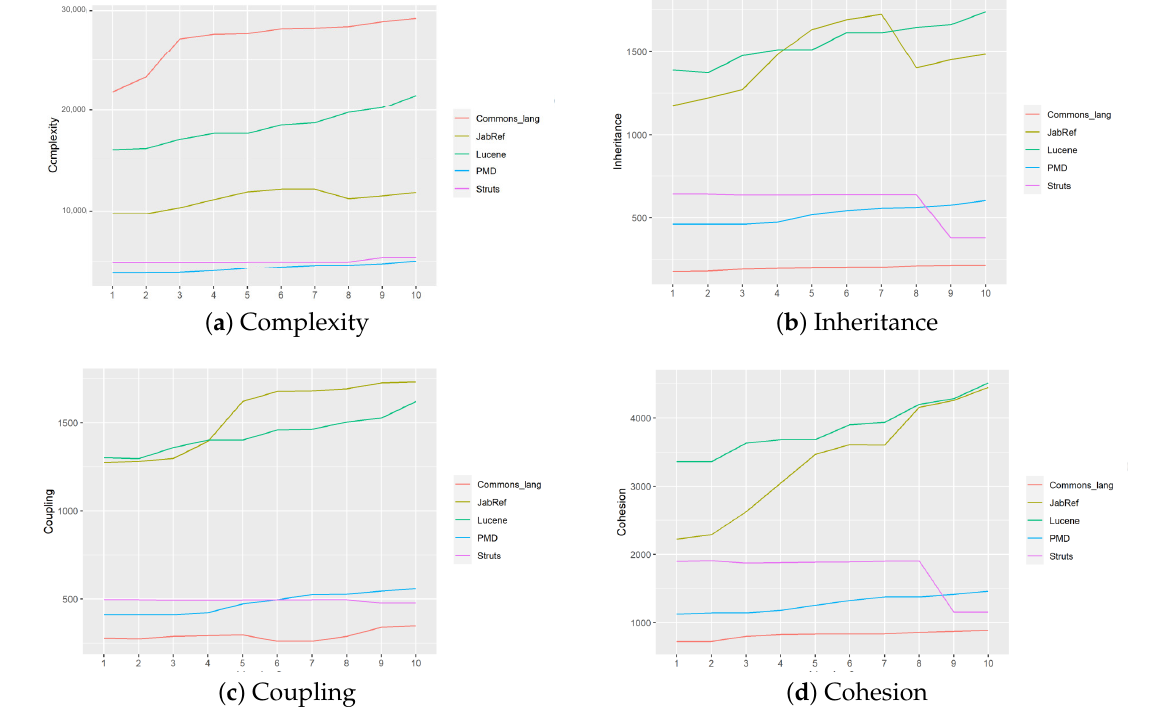
Figure 3. Change of Internal Quality Attributes over Versions.